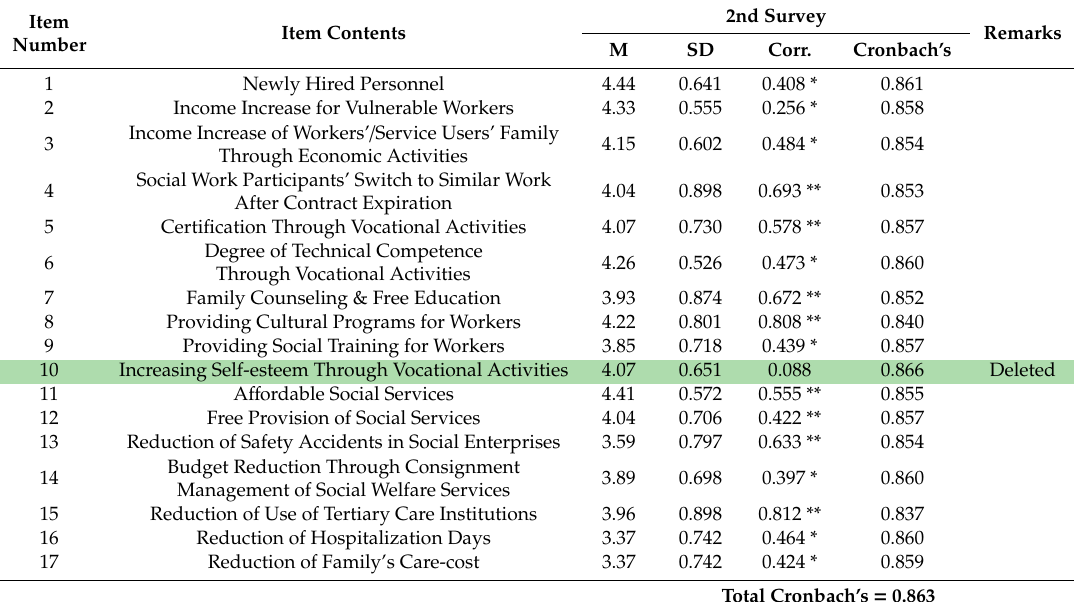
Table 3. Validity and Reliability of Social Value Items in Social